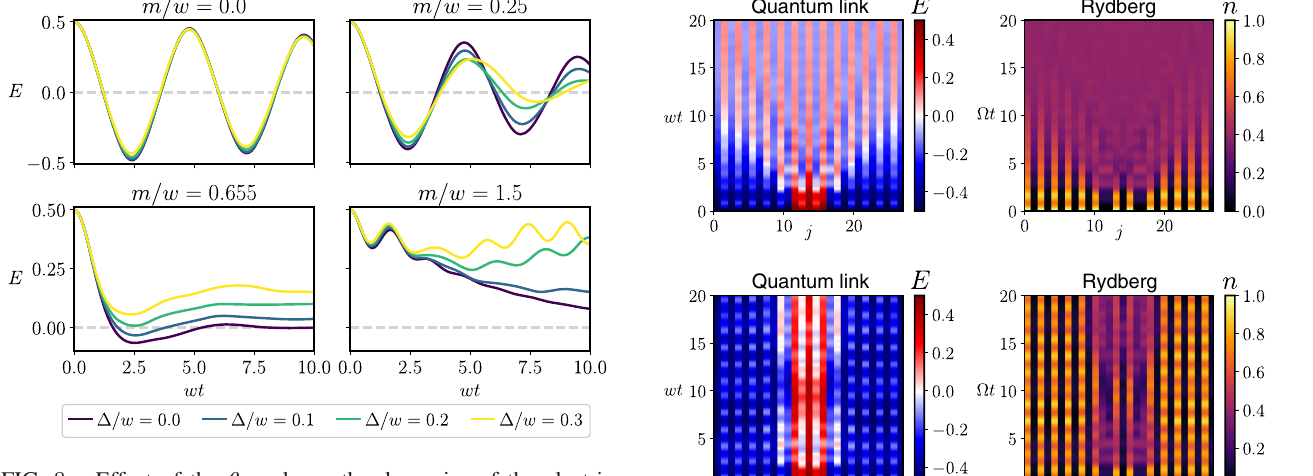
FIG. 8. Effect of the θ angle on the dynamics of the electric field from uniform string states of the QLM. Data are shown for a chain of L ¼ 28 sites, for increasing values of the particle mass m=w and of the parameter Δ , quantifying the deviation of the θ angle from π (see the main text). Dynamics for Δ ¼ 0 correspond to the second column of Fig. 2.